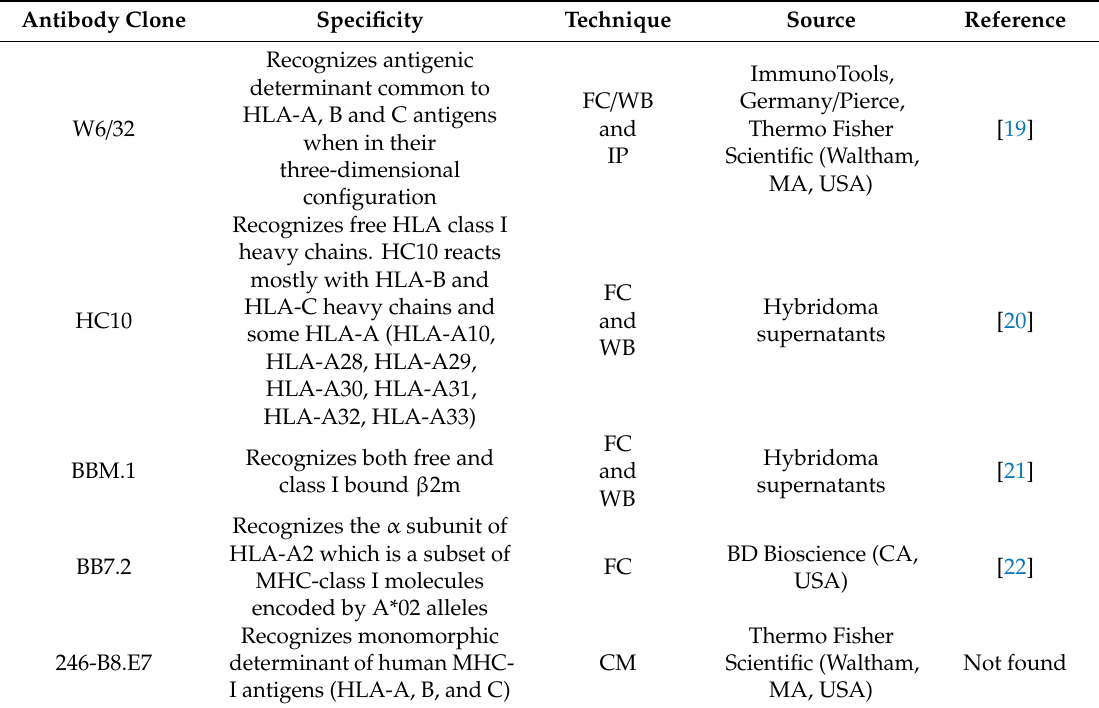
Table 1. List of anti-MHC-I antibodies used in this